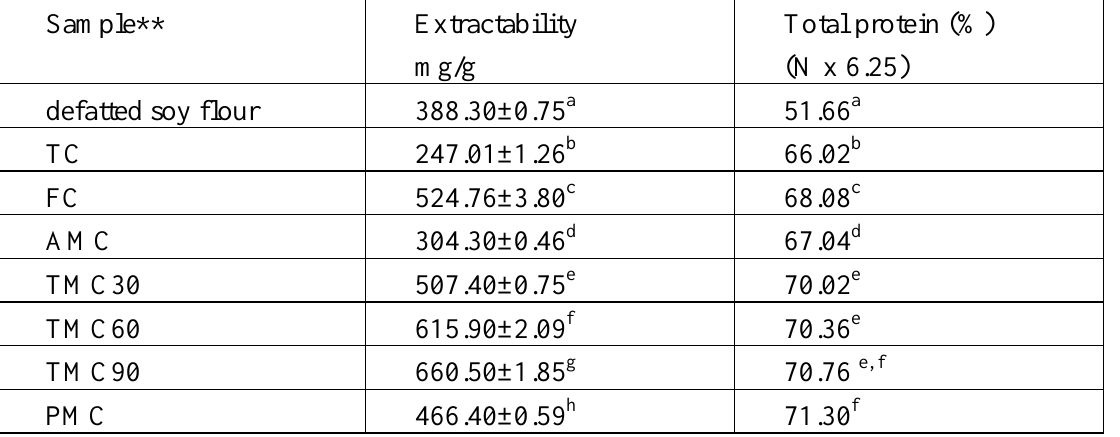
Table 1 . Extractability of the traditional, functional and the modified soy protein concentrates*